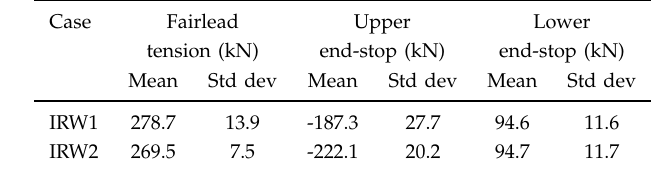
TABLE VII M EAN AND STANDARD DEVIATION OF MAXIMUM FAIRLEAD TENSION , UPPER AND LOWER END - STOP FORCES FOR THE IRW1 AND IRW2 CASES USING d = 5